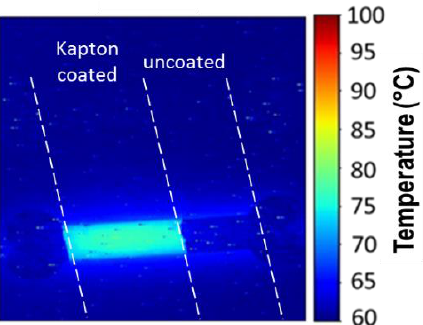
Figure 13. Effect of Kapton coating on thermal IR measurement.